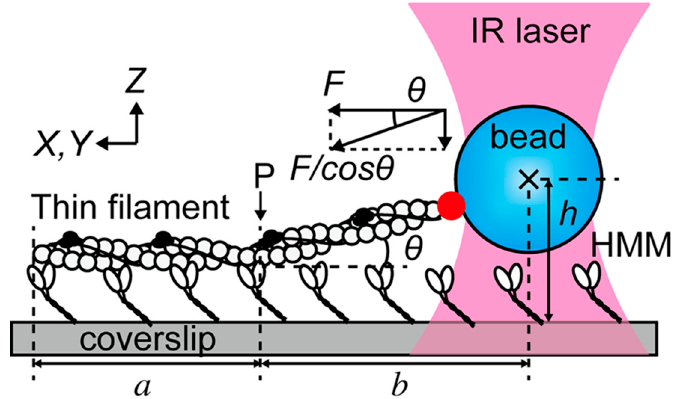
Figure 5. Experimental setup used by Ishii et al. [91]. The filament made of actin, tropomyosin, and troponin is attached to the coverslip for a length a up to the point P by its interaction with heavy meromyosin molecules (HMM). One end is connected to a polystyrene bead trapped by an infrared (IR) laser. The filament is labeled with fluorophores and imaged using widefield techniques. Optical tweezers measure the intensity of the force F /cos θ , while fluorescence allows to estimate both the lengths h and b ; in this way, the z -component of the force can be reconstructed. Reprinted with permission from [91].